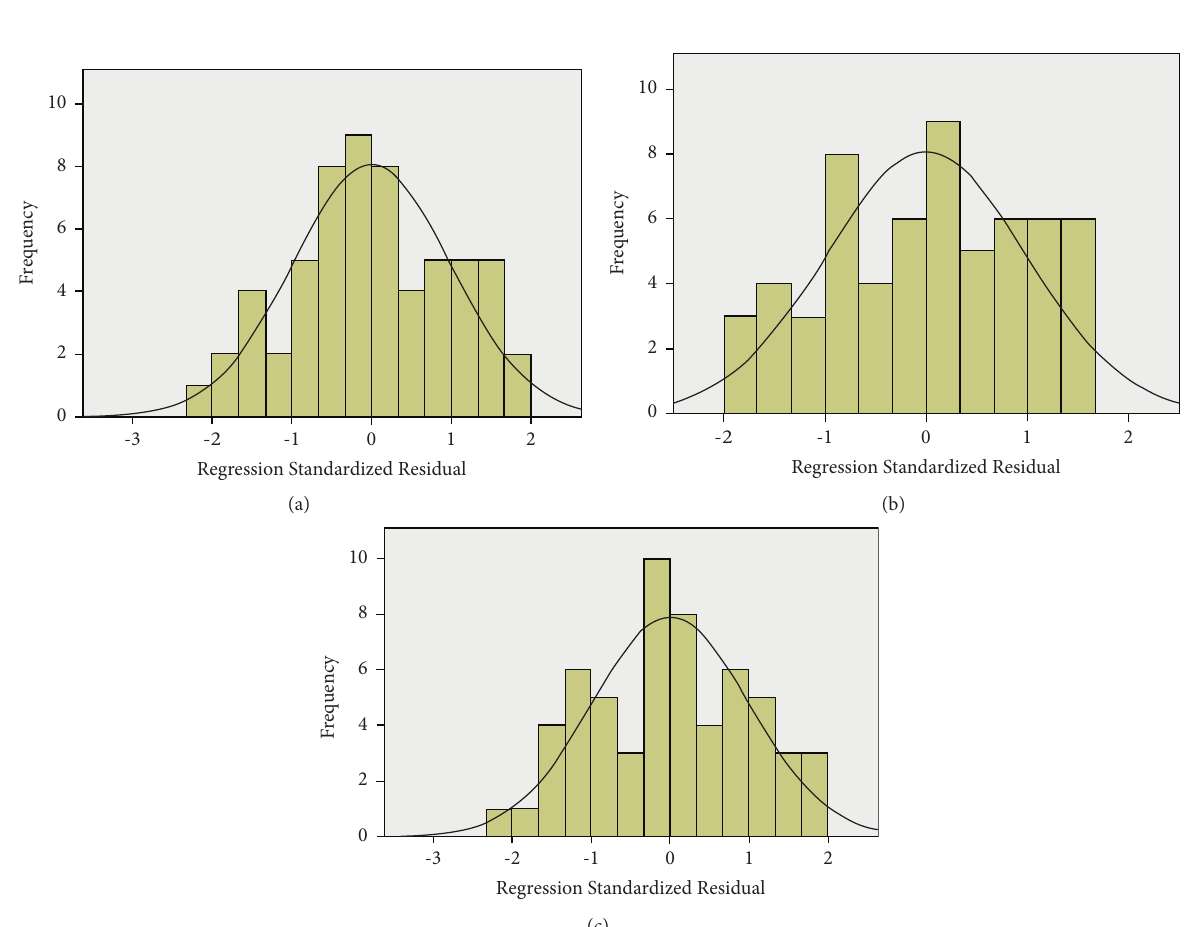
Figure 28: Residual histogram of the maximum lateral acceleration model in the simple horizontal curve. (a) Sedan. (b) SUV. (c)